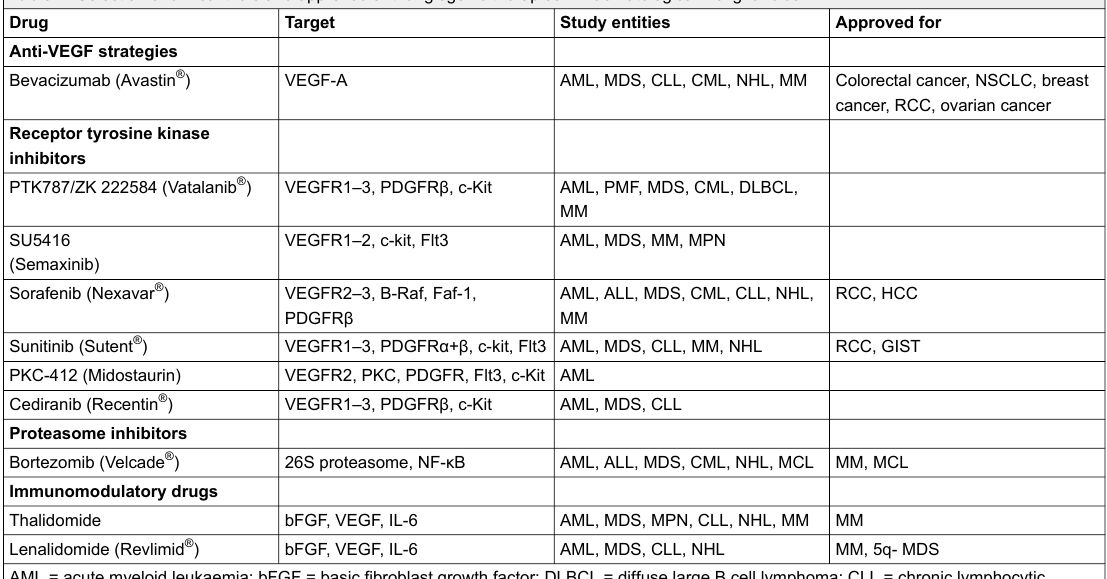
Table 1: Selection of clinical trials and approved anti-angiogenic therapies in haematological malignancies. Drug Target Study